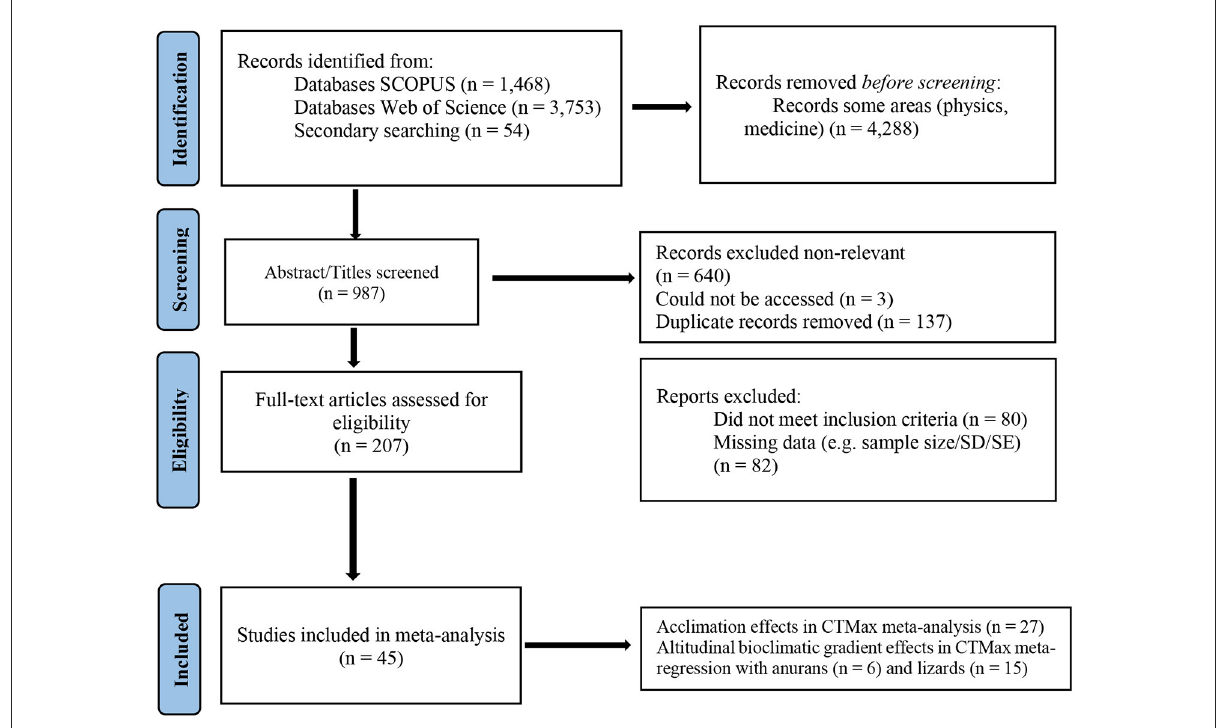
FIGURE1 PRISMA flow diagram adapted from Page et al. (2021) showing literature search procedures and screening processes.